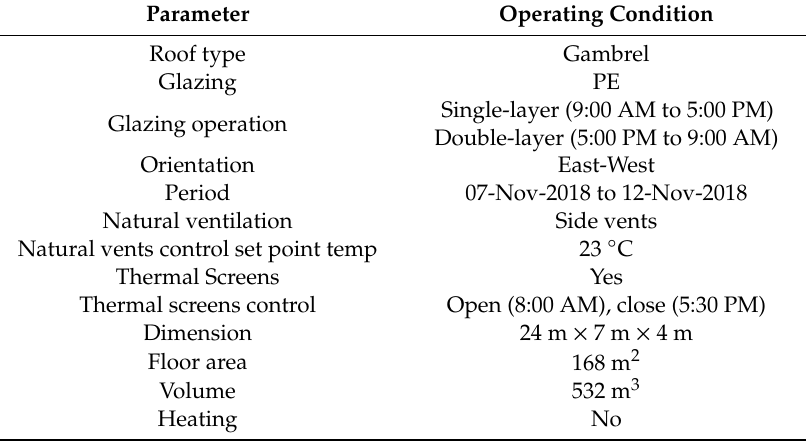
Table 7. Summary of reference greenhouse with temperature controlled natural ventilation and thermal